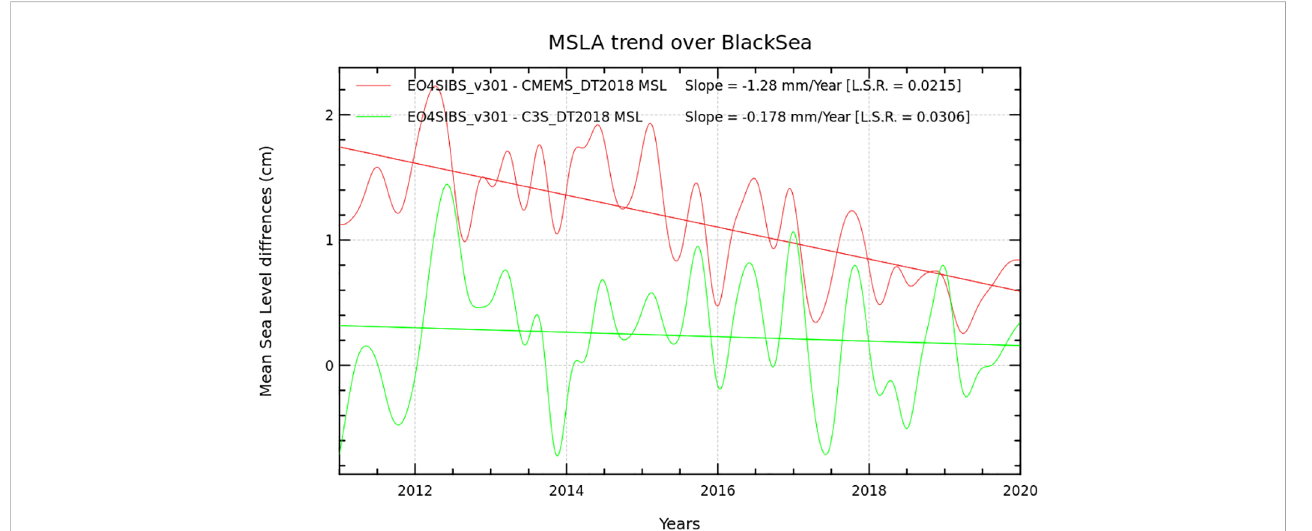
FIGURE 12 Difference of the Black Sea MSL trend estimation from EO4SIBS and Copernicus Marine Service (DT-2018 version) gridded products (red line) and from EO4SIBS and C3S (DT-2018 version) gridded products (green